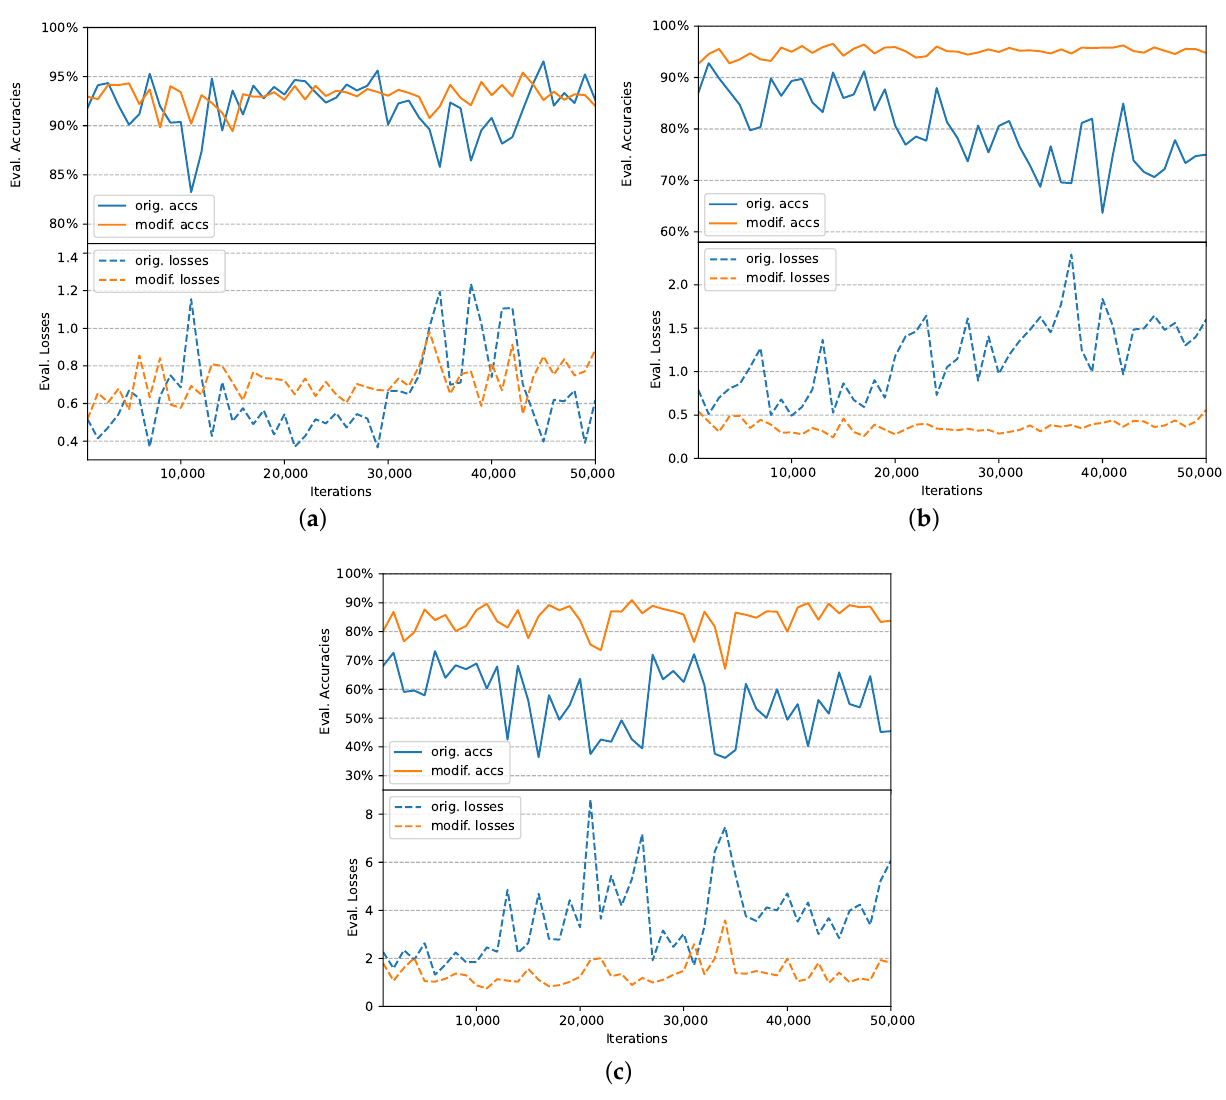
Figure 11. Evaluation accuracies and losses comparisons with the baseline model during training. ( a ) UC Merced dataset; ( b ) NWPU-RESISC45 dataset; ( c ) AID